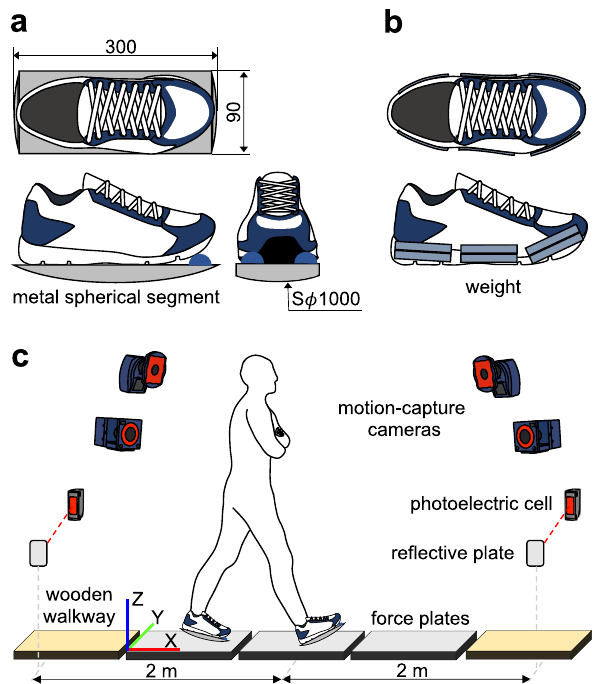
Figure 1. Point-contact (PC) shoe ( a ), normal (NL) shoe ( b ), and experimental setup ( c